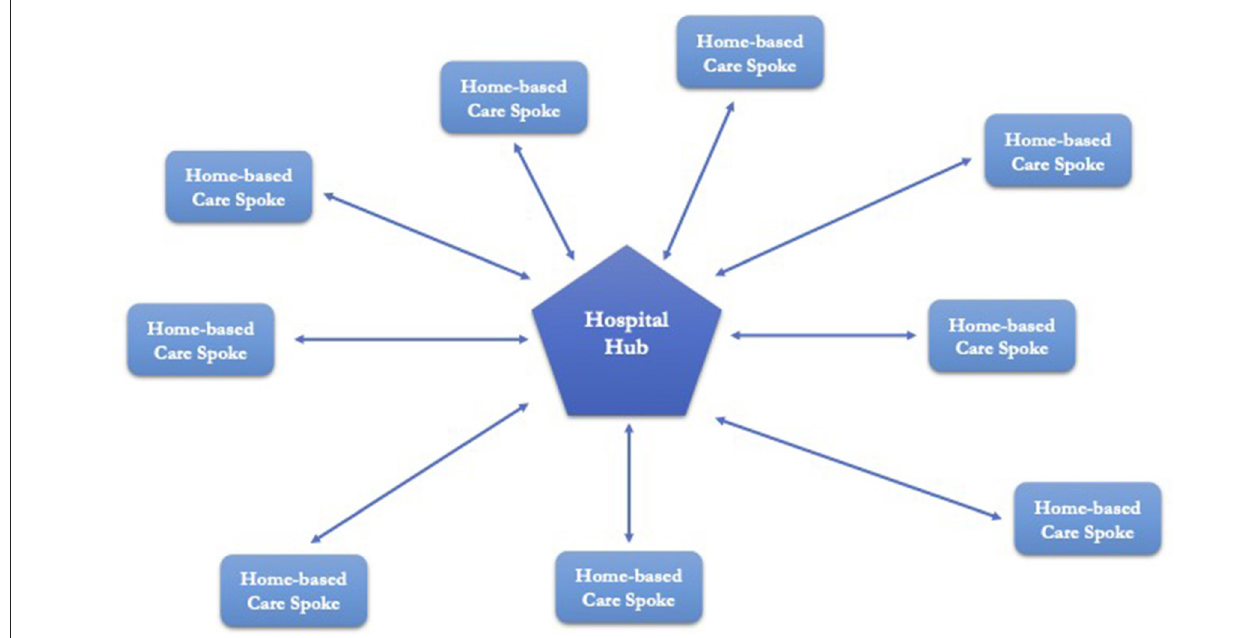
FIGURE 3 | “Hub and Spoke” organizational